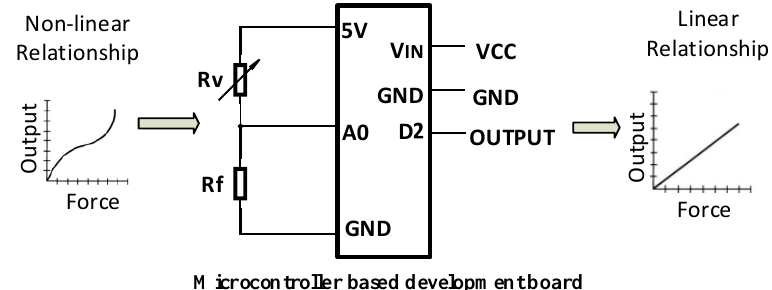
Figure 18. Developed electric circuit.